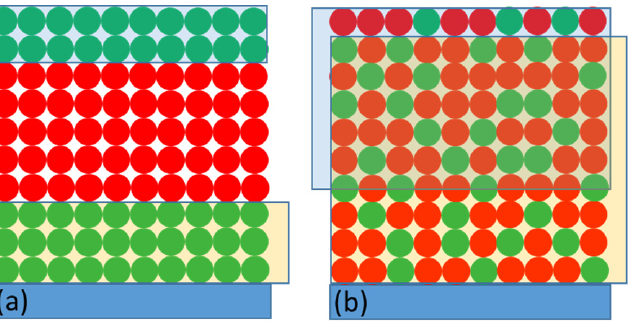
Figure 11. ( a , b ) Two models of the active (green) vs. inactive (red) PSI particles distribution across their multilayer on the FTO substrate. Semi-transparent yellow and blue rectangles are the areas of the effective P + re-reduction by the low voltage ( − 180 mV) and by redox compounds (10 mM ascorbate and 200 µ M DCPIP), respectively.